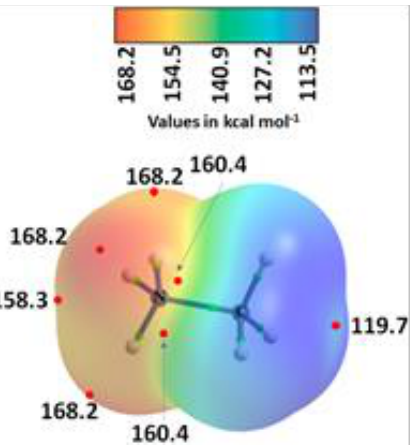
Figure 6. MP2/Aug-cc-pVTZ level 0.001 a.u. isoelectron density-envelope-mapped potential on the electrostatic surface of methylammonium, CH 3 NH 3+ ). There are no local most potential minima ( V S , min ), but only local most maxima V S , max (tiny red circles) identified on the surfaces of the two N atoms along the N – N bond extensions, and around the central region of the N – N covalent bond.